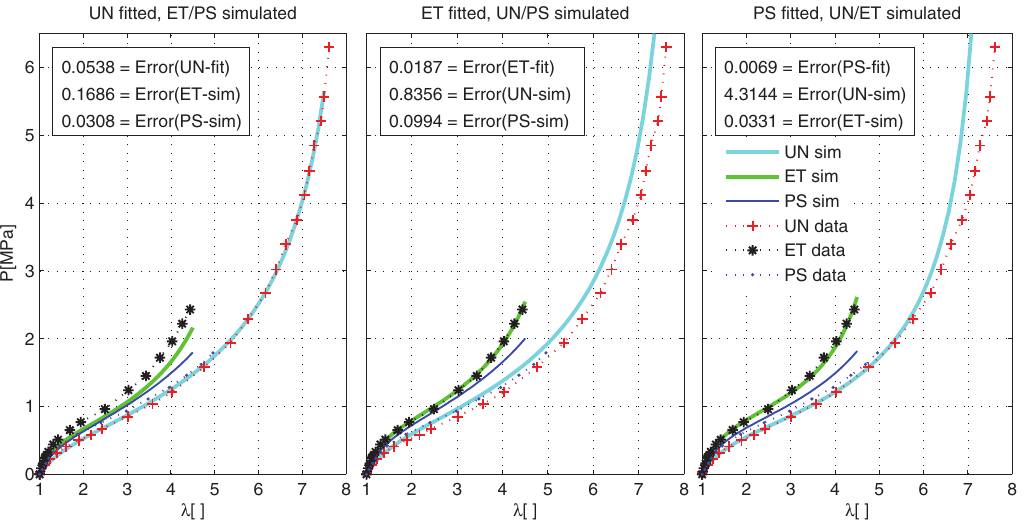
Figure 6: Performance of the Meissner-Mat ě jka model on the Treloar data. The fitting quality and model predictions are excellent in all deformation